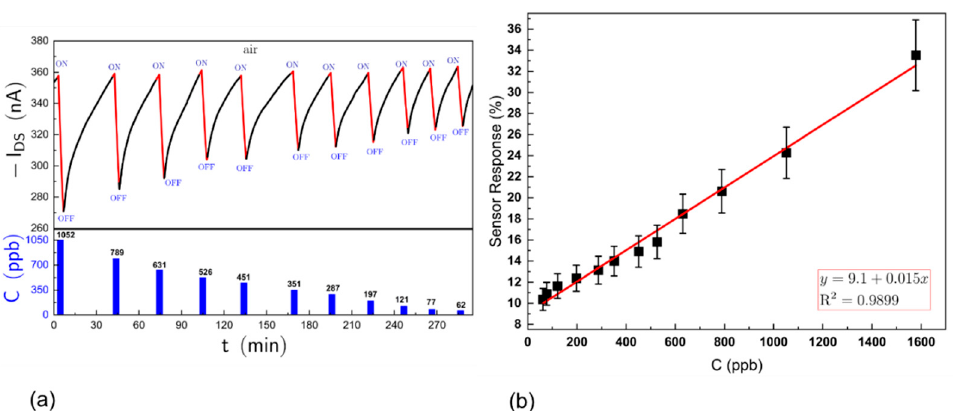
Figure 6. ( a ) Top—raw responses to a series of pulses of triethylamine vapour in dry air. Bottom—duration of vapour pulse sequence between 1052 and 62 ppb; and ( b ) concentration–response curve for triethylamine vapour.